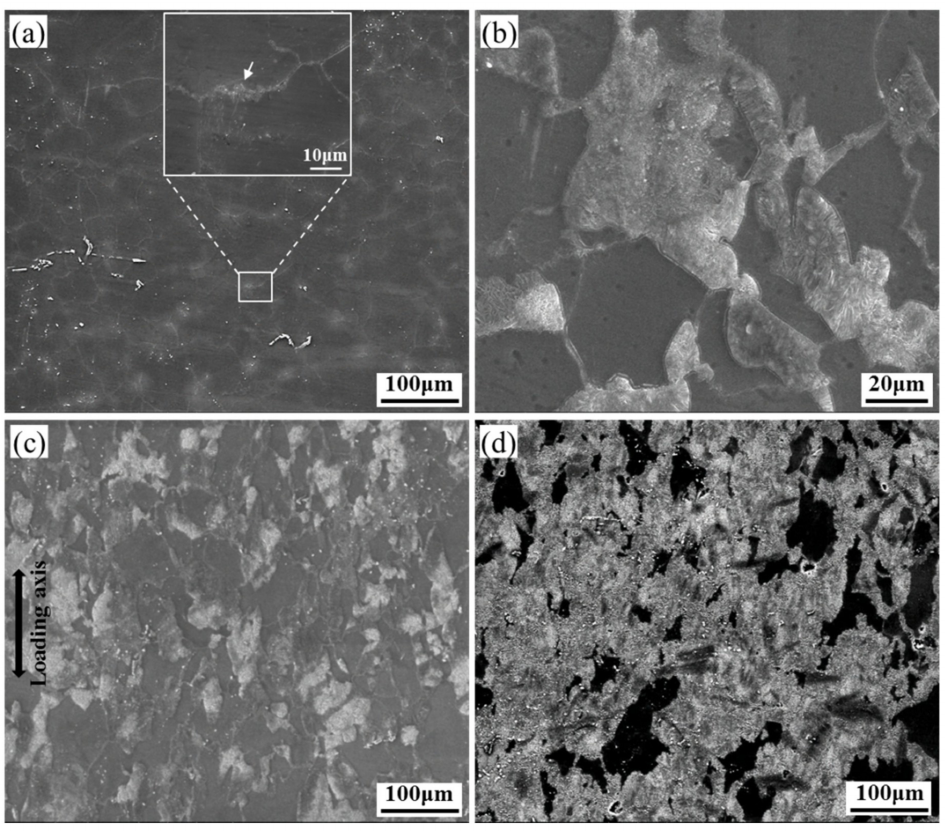
Figure 6. SEM images of HRRed specimens crept at ( a ) 120 ◦ C / 80 MPa to 100 h, 150 ◦ C / 80 MPa to ( b ) 35 h and ( c ) 100 h, and ( d ) 175 ◦ C / 80 MPa to fracture.